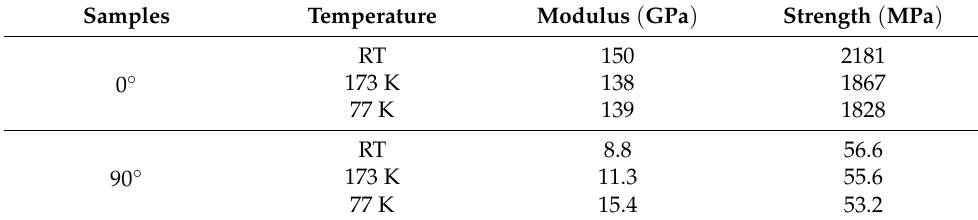
Table 2. Tensile properties of single-layer plate at different temperatures